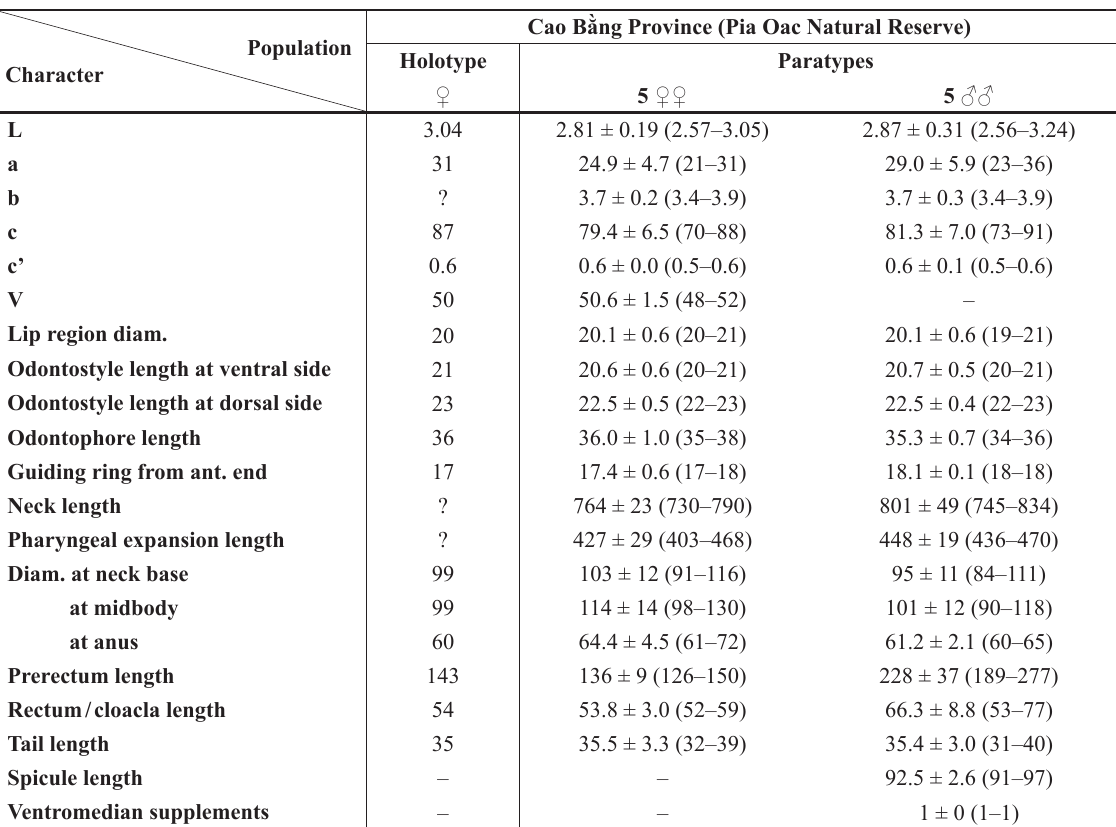
Table 1. Morphometrics of Sectonema tropicum sp. nov. Measurements in μm (except L, in mm), and in the form: mean ± standard deviation